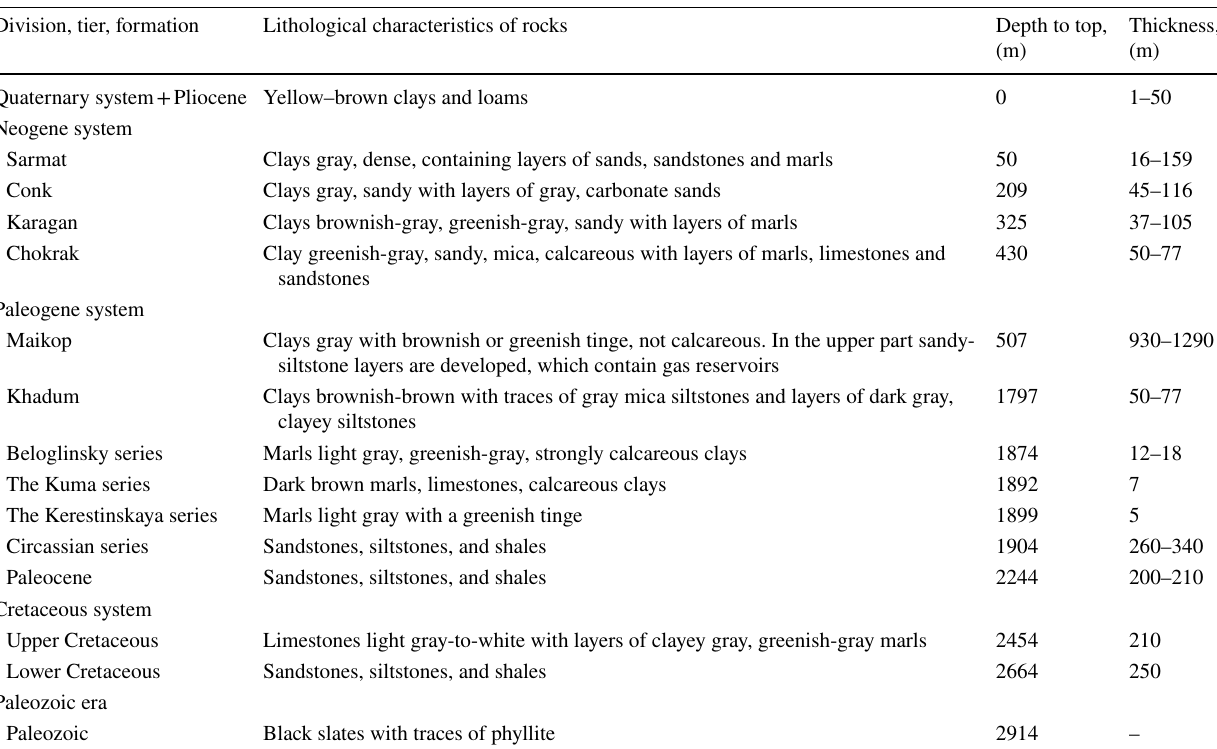
Table 2 Stratigraphical and lithological characteristics of the Blagodarnenskaya structure Division, tier,